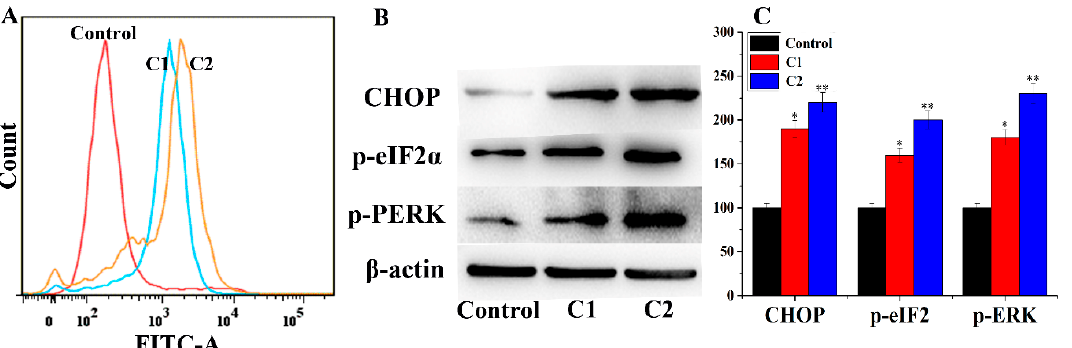
Figure 7. (A ) A-549 cells treated with C1 and C2 and analysis of Ca 2+ concentration. ( B ) Western blot